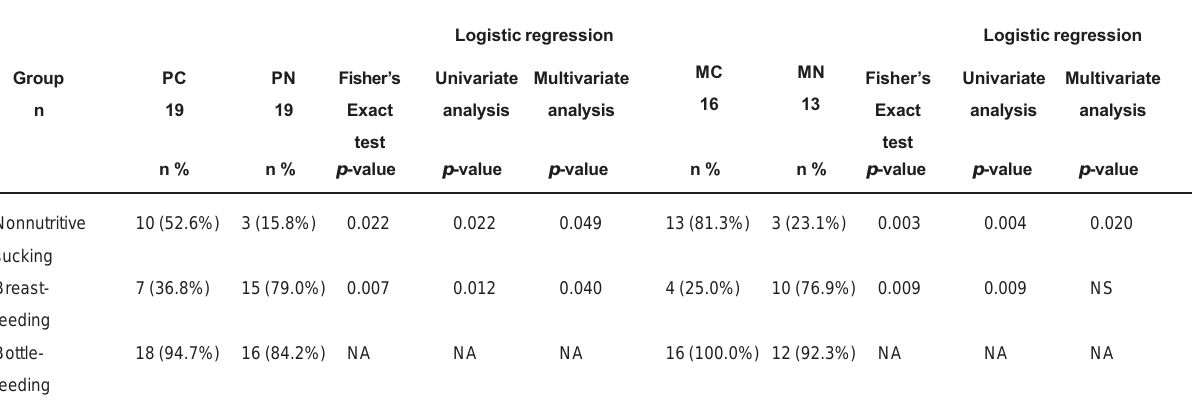
Table 2- Sample distribution according to the presence of nutritive and nonnutritive sucking habits and the results of statistical analysis